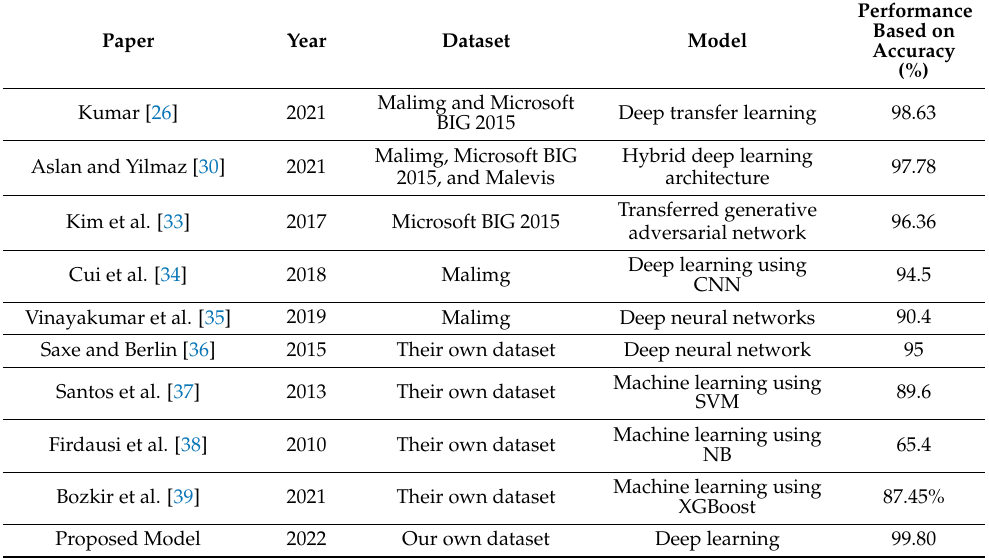
Table 9. Comparing the proposed method results with other existing literature studies that use deep learning and